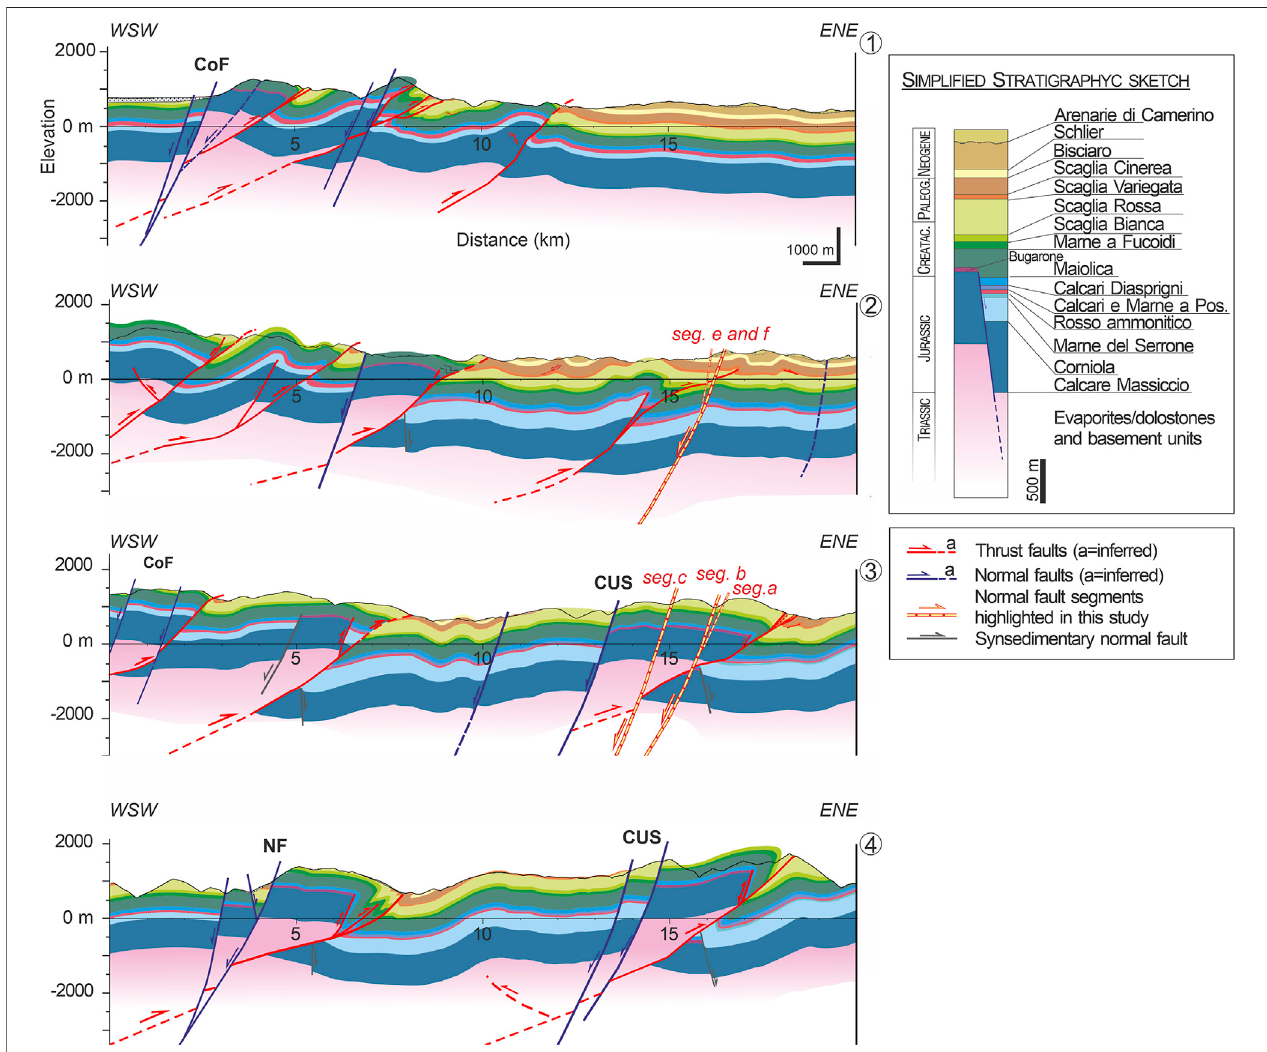
FIGURE7| Newinterpretativegeologicalcross-sectionacrossthestudyarea(traces in Figure1B ).drawnstartingfrompublishedgeologicalmaps(1:25,000 and 1:40,000, from Barchi et al. (2012) and Pierantoni et al. (2013), respectively) and integrated with the evidence of faulting highlighted in this study. Segments (seg) are labeled as in Figure 9A